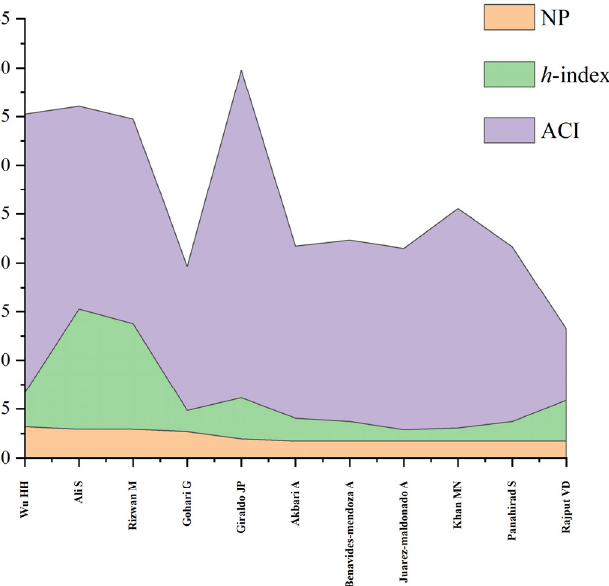
Figure 3. The number of publications (NP) of the most productive authors and their corresponding h –index, ACI.